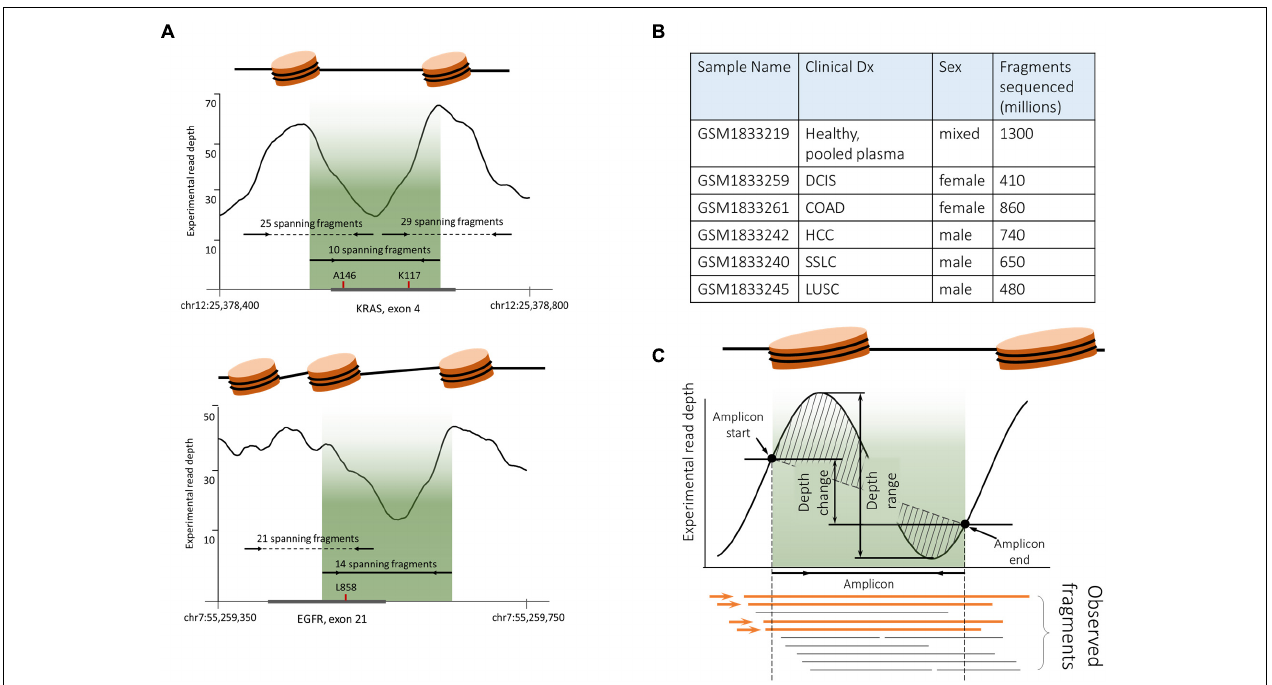
FIGURE 5 | Plasma cfDNA fragmentation pattern biases analytical characteristics of PCR-based somatic detection system. (A) ITCHP2 primer panel design mapped to the nucleosome guided cfDNA fragmentation pattern indicates a possible bias in amplification effectiveness. Experimental coverage was assessed based on the pair-end WGS plasma sequencing of healthy individuals (GSM1833219). Fragment counts were calculated as WGS captured and sequenced fragments (continued read pairs), completely covering the amplicon of interest. Localization of the ITCHP2 panel amplicon (solid line with arrows, indicating primers as well as lightened area) in local minimum would result in the lack of availability for the amplification of cfDNA fragments. Shifting amplicons (dotted lines) within clinically relevant mutations may result in an increase of available fragments and thus amplification effectiveness. A146 and K117 indicates clinically relevant KRAS mutation hotspots in the exon of interest. A similar situation can be observed for the EGFR L858R mutation and respective amplicon design – moving amplicons within clinically relevant mutation site mutations may result in increased coverage uniformity. (B) Publicly available cfDNA WGS sequencing data [PRJNA291063] was used to generate cfDNA fragmentation maps. (C) . In order to decipher the complex variable of the cfDNA fragmentation pattern and its mapping to amplicons positions and lengths, four features were introduced, namely, observed fragments (Feature A), depth range (Feature B), depth change (Feature C), and depth shape (Feature